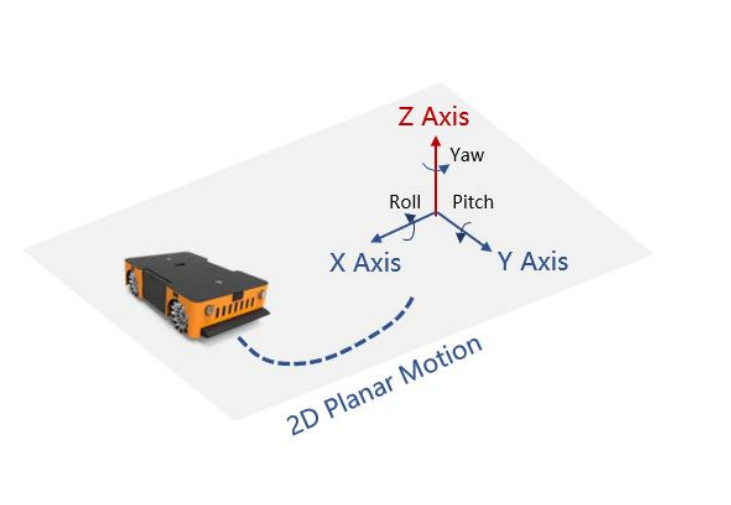
Figure 1. An AGV moving in 2D plane and its coordinate